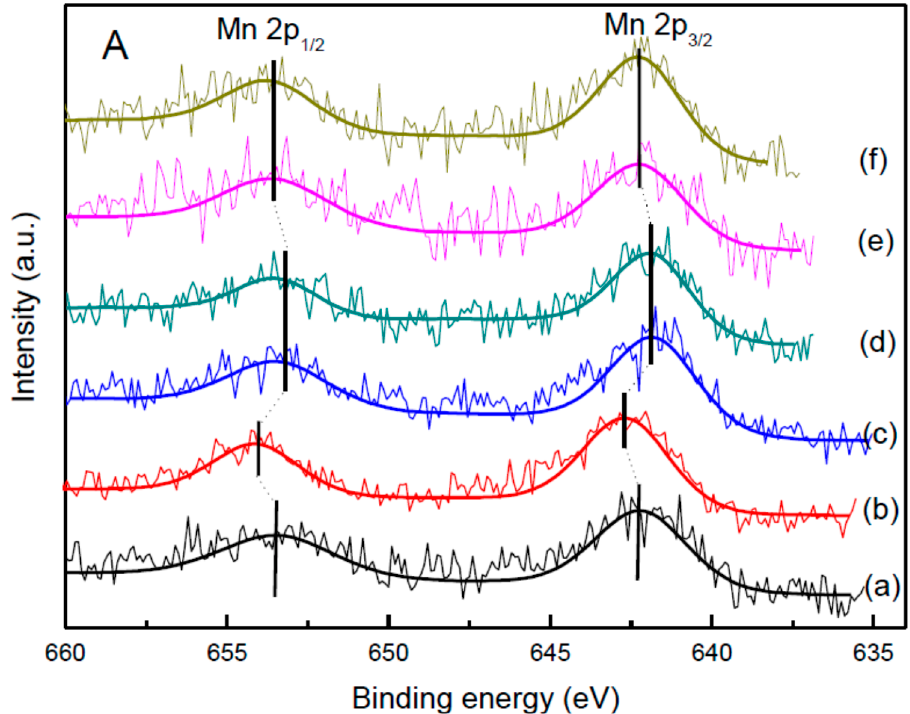
Figure 6. Mn 2p X spectra of catalysts before and after the reaction in the presence of SO 2 . ( a ) Fresh MnZr; ( b ) used MnZr; ( c ) fresh MnCeZr; ( d ) used MnCeZr; ( e ) fresh MnYZr; ( f ) used MnYZr.